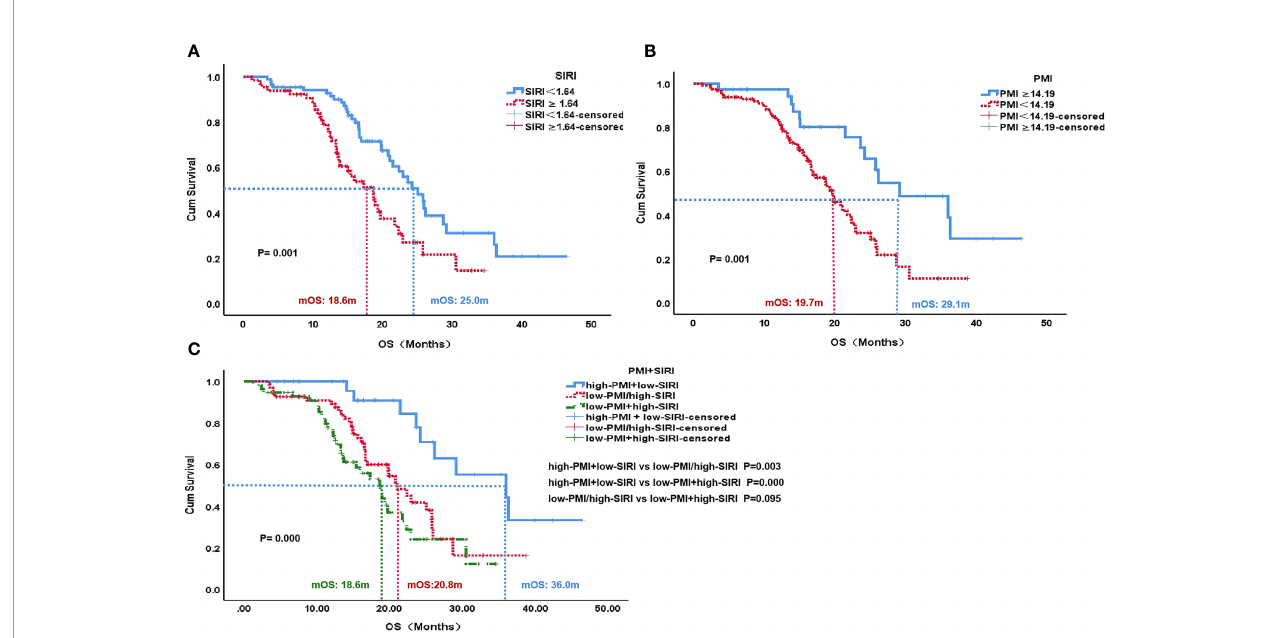
FIGURE 3 | OS according to SIRI status (A) , PMI status (B) and PMI+SIRI status (C) in the patients with HCC. OS, overall survival; SIRI, systemic in fl ammation response index; PMI, psoas muscle